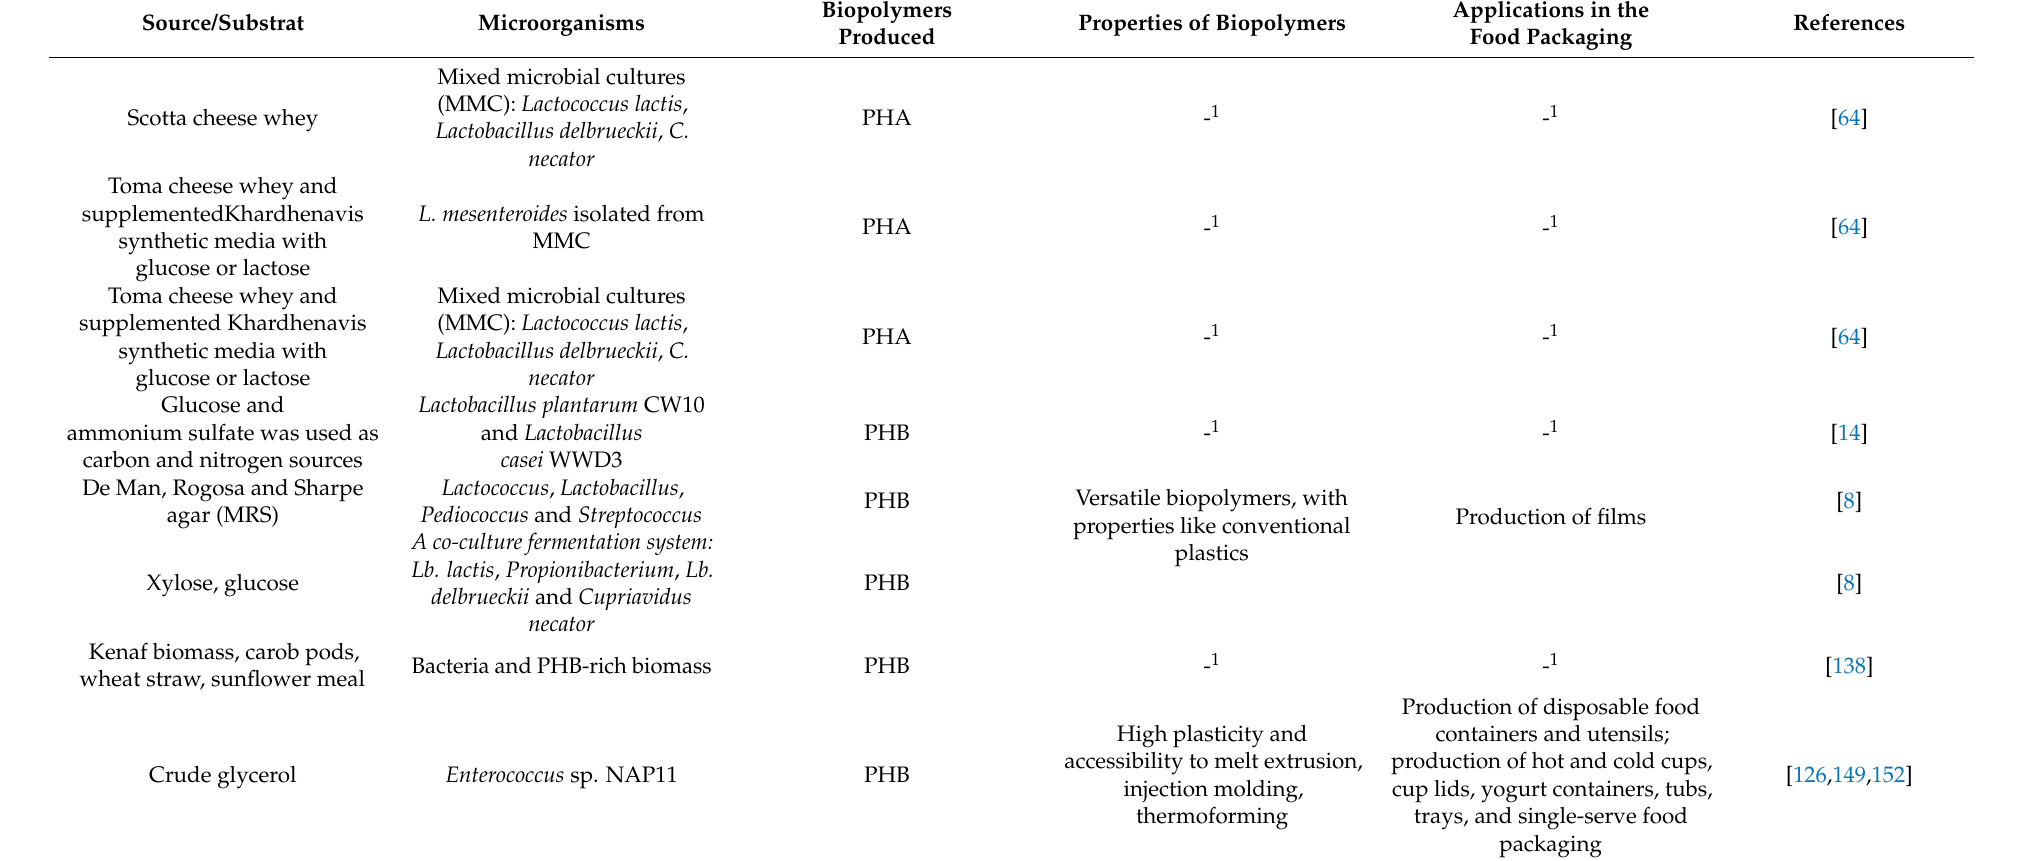
Table 3. Applications of PHAs and PLA biopolymers produced by LAB in the food packaging